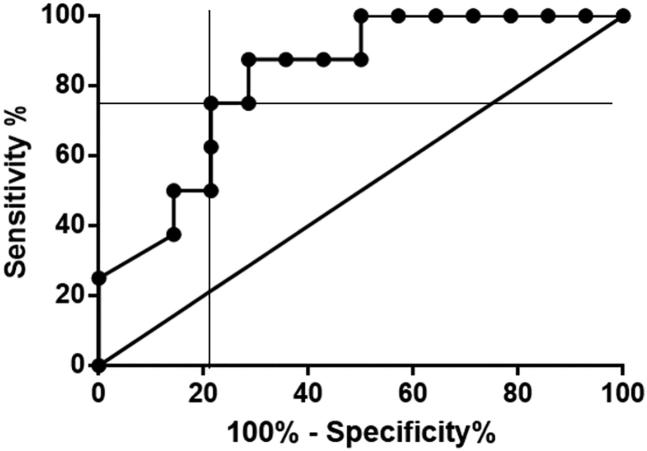
Receiver operating characteristic curve illustrating the sensitivity and specificity for the use of HMGB1 to distinguish dogs with AP and SIRS from those with AP but no SIRS. The thick diagonal line represents a completely uninformative test, wherein the area under curve is 50%. The area under the curve of the receiver operating characteristic curve represented by the thicker line is 0.82 (95% CI = 0.6462–0.9967). The point of intersection indicates the optimal cut-off of 0.35 ng/mL for the differentiation between AP dogs with and without SIRS, with corresponding sensitivity and specificity of 87.5% (47.35–99.68%) and 71.43% (41.90–91.61%). AP, acute pancreatitis; HMGB1, high mobility group box 1; SIRS, systemic inflammatory response syndrome.